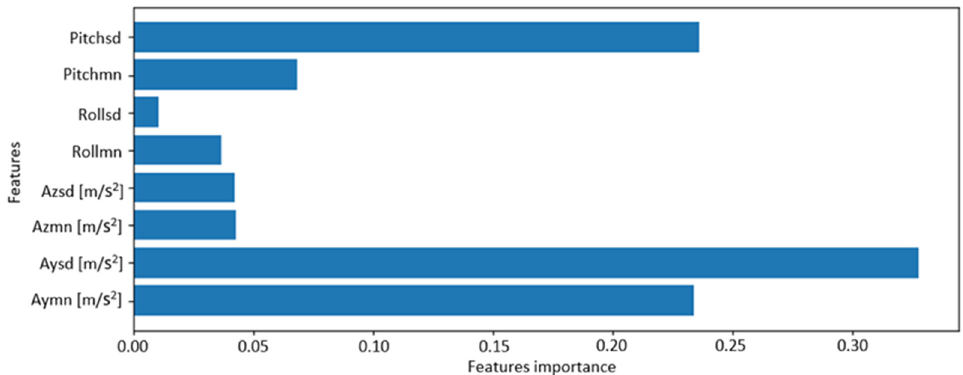
Figure 12. Importance of pre-selected features obtained with help of a decision tree classifier.